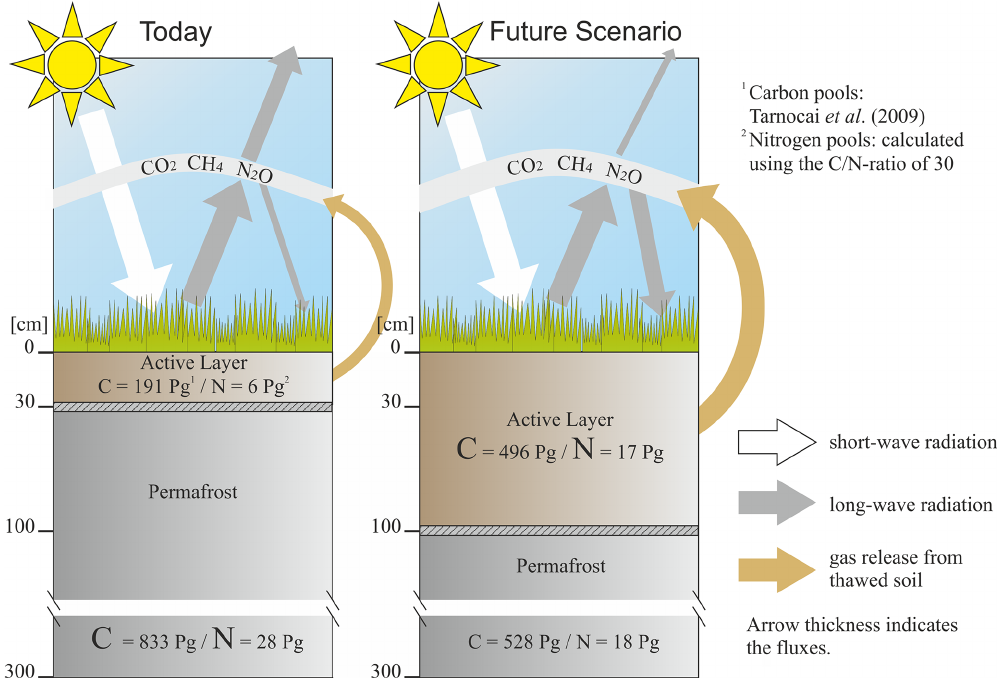
Figure 8. Schematic illustration of the carbon and nitrogen dynamic feedbacks and the climate-driven changes within the permafrost-affected soils. C pools (Tarnocai et al., 2009) and N pools calculated using the C / N ratio of 30. Figure according to Beer